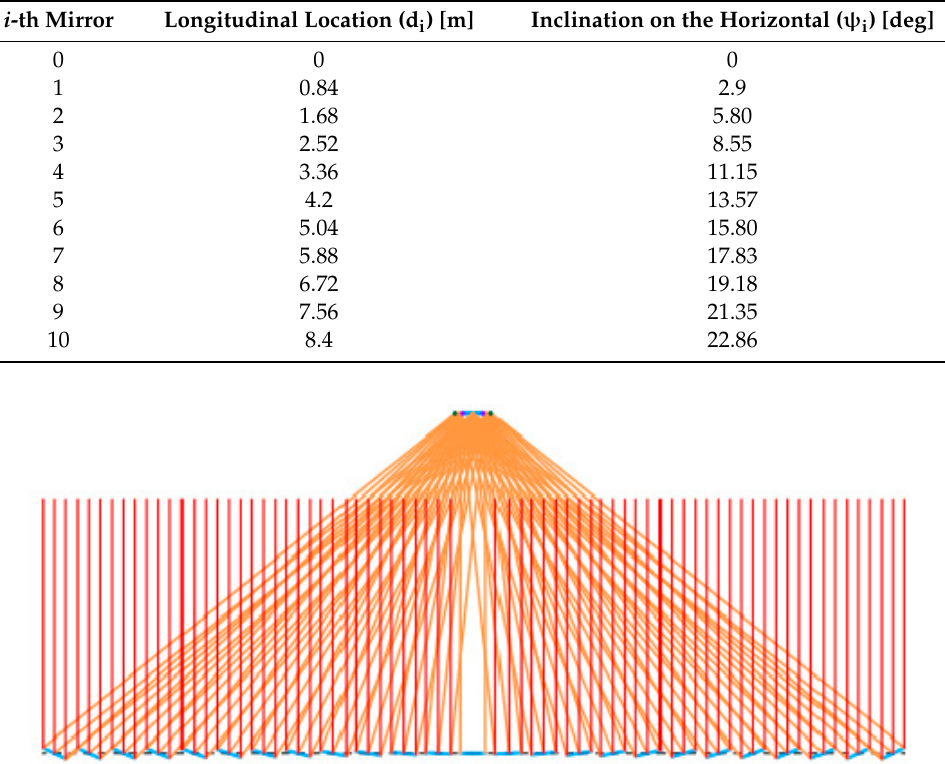
Figure 7. Arrangement of the Fresnel reflector mirrors. Table 2. Position of the primary mirrors at solar noon ( ω (cid:3404) 0 ; Γ (cid:3404) 0.5753 ).